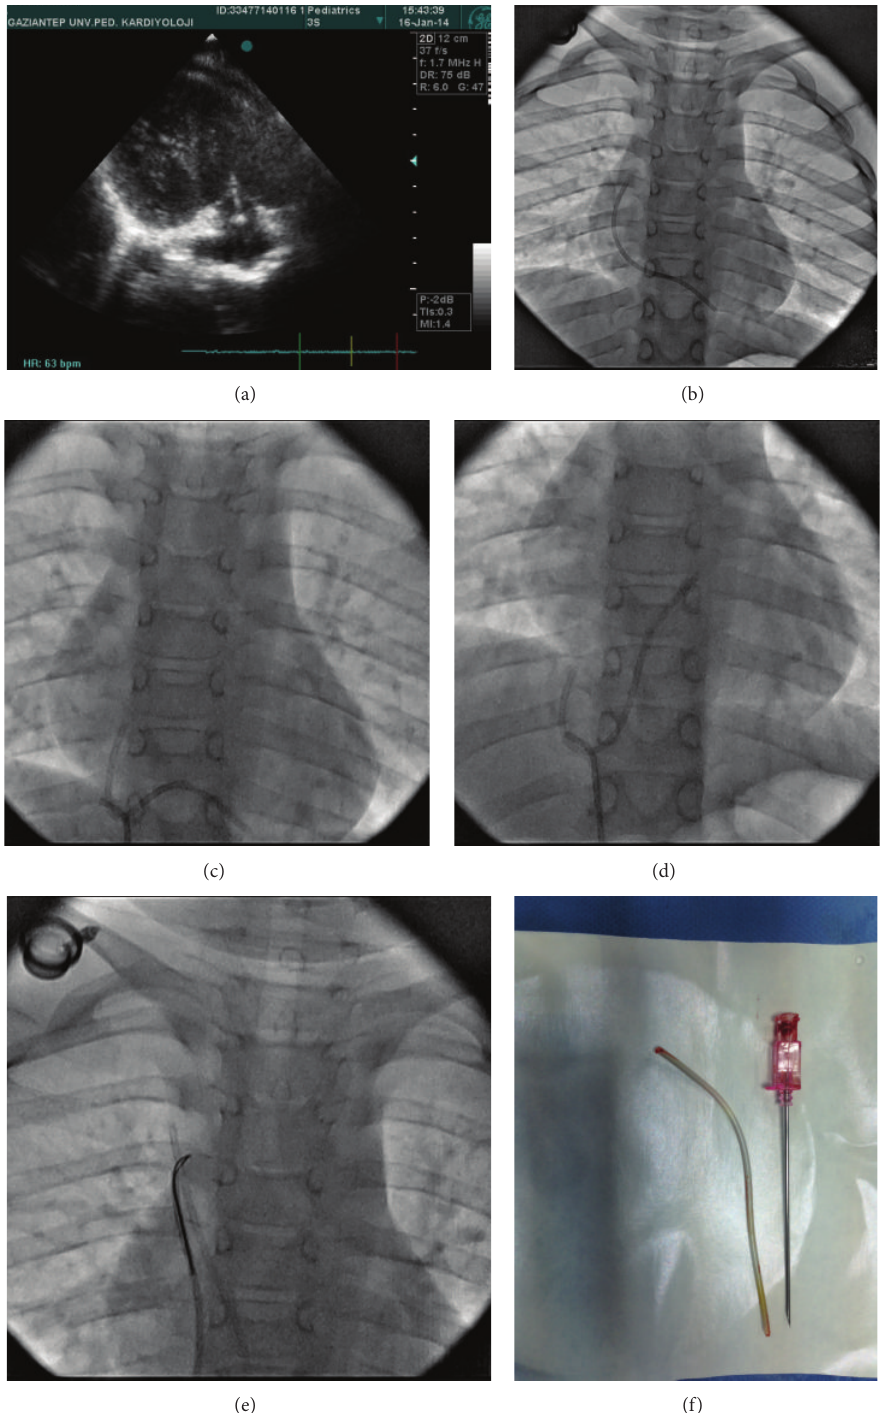
Figure 2: (a) Echocardiographic and (b) angiographic images of a catheter extending to the right ventricle apex from the right atrium roof in a 6-year-old child. ((c), (d), and (e)) Images of its retrieval using a Judkins right catheter as a hook to snare the catheter are shown. (f) The embolized port